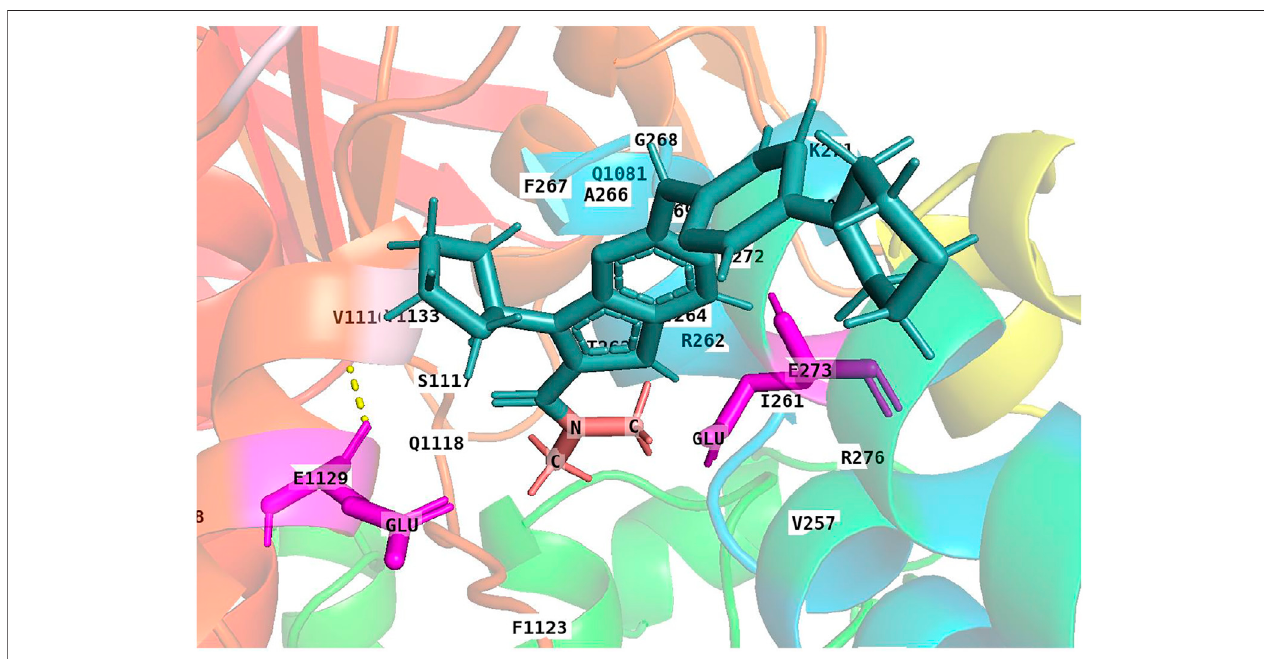
FIGURE 4 | A 3-D structural model showing the electrostatic interaction between ribociclib and P-gp. Under physiological conditions, the N,N-dimethylamide cluster is positively charged and may bind to a cavity containing E273 and E1129 with negative charges due to the dissociation of hydrogen protons from the carboxyl group at neutral or higher pH